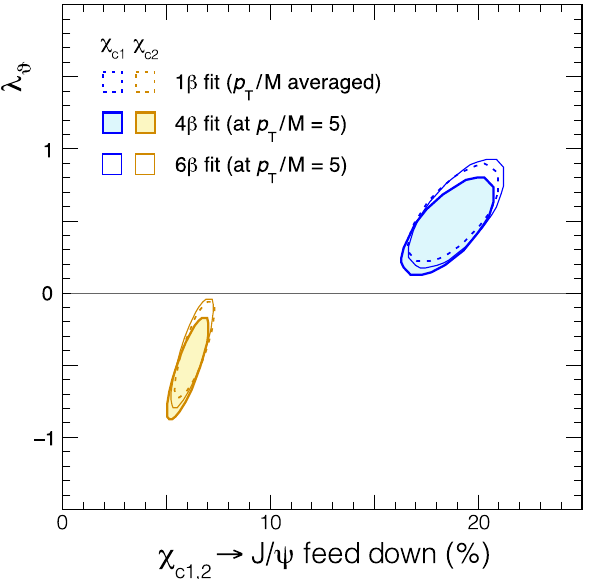
Fig. 10 Two-dimensional distributions showing the correlation χ c 2 λ χ c 1 β fit variant, when between the λ ϑ and ϑ polarizations, in the 1 using three sets of measurements: only the direct χ cJ polarization data χ c 2 − λ χ c 1 [30] (blue), which essentially constrains the λ ϑ ϑ difference, all χ c 1 + λ χ c 2 the other data (red), mostly constraining the λ ϑ ϑ sum, and the result of the global fit presented in this paper (pink)